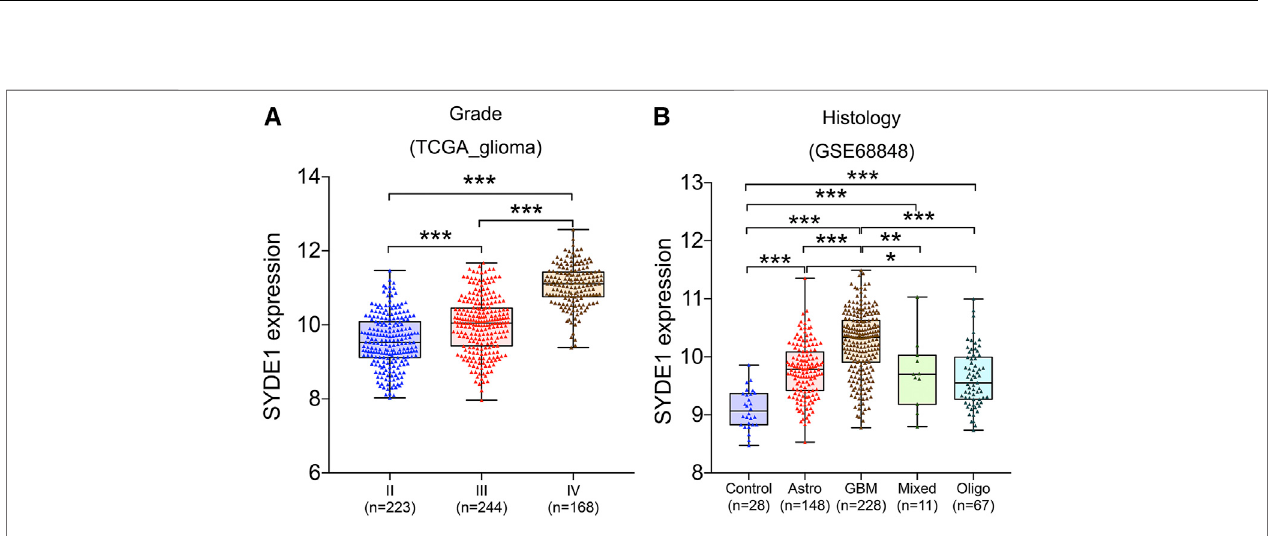
FIGURE 3 | The association between SYDE1 expression and glioma grade or histology. (A) The association between SYDE1 expression and glioma grades. (B) The association between SYDE1 expression and glioma histology. *, p.value < 0.05; **, p.value < 0.01; ***, p.value < 0.001.